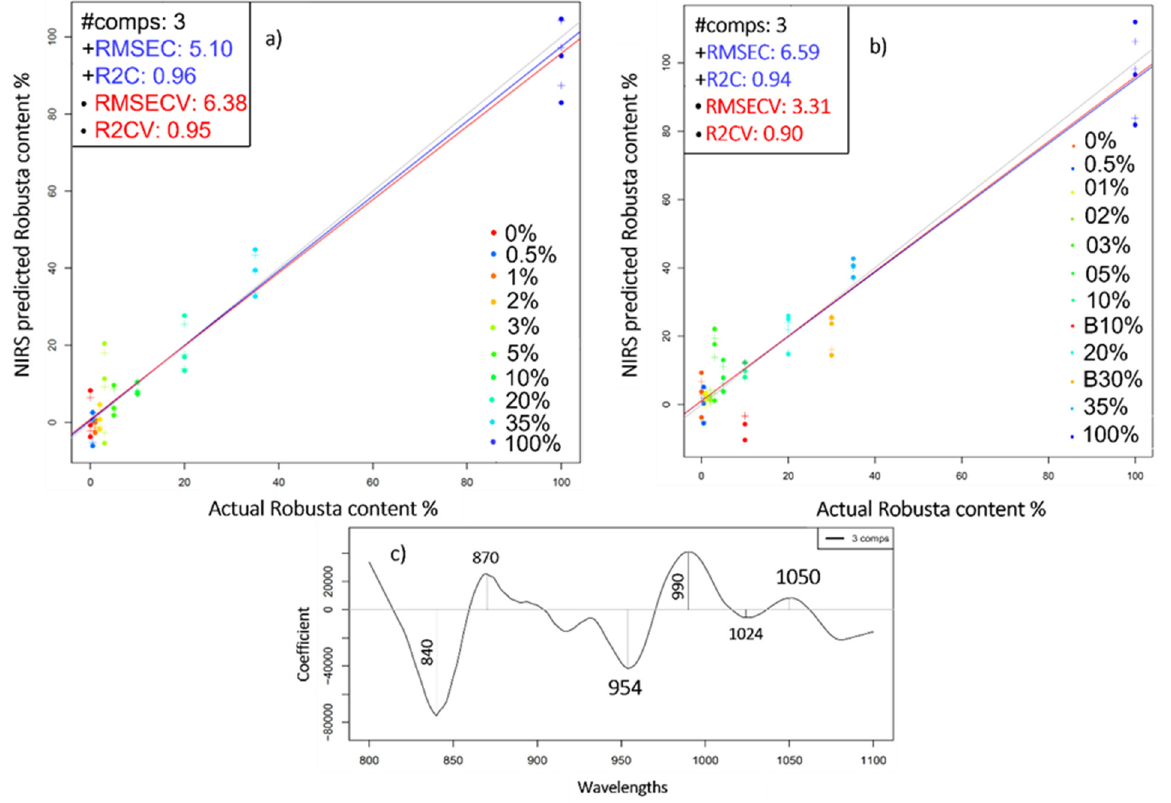
Figure 8. ( a ) Y-fit graph of the prediction of Robusta concentration in liquid mixtures N = 30; ( b ) PLSR analysis on the dataset containing marketed blends B10% and B30% and the mixtures, N = 36; ( c ) Regression vector of the predictive model ( b ) in the 800–1100 nm range. Spectral pre-processing: Averaging consecutive scans, Savitzky-Golay smoothing (window size 19), 1st derivative.